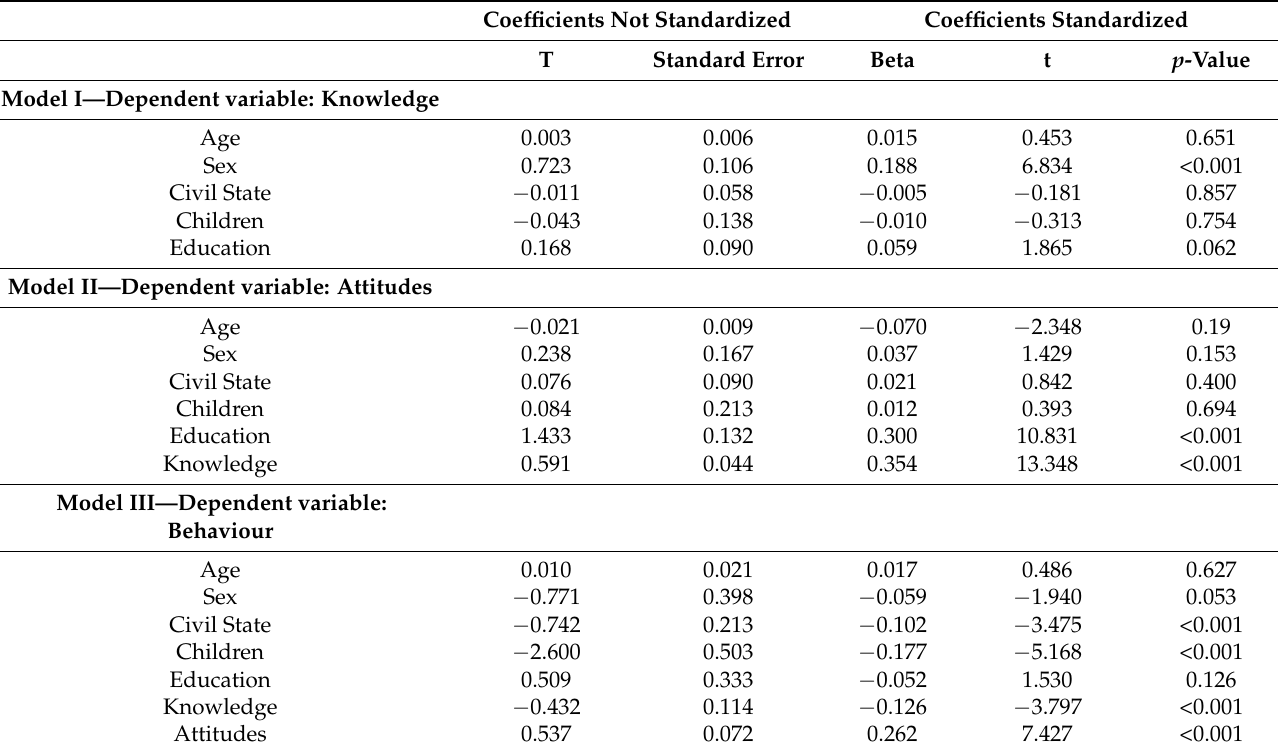
Table 5. Results of the linear multiple